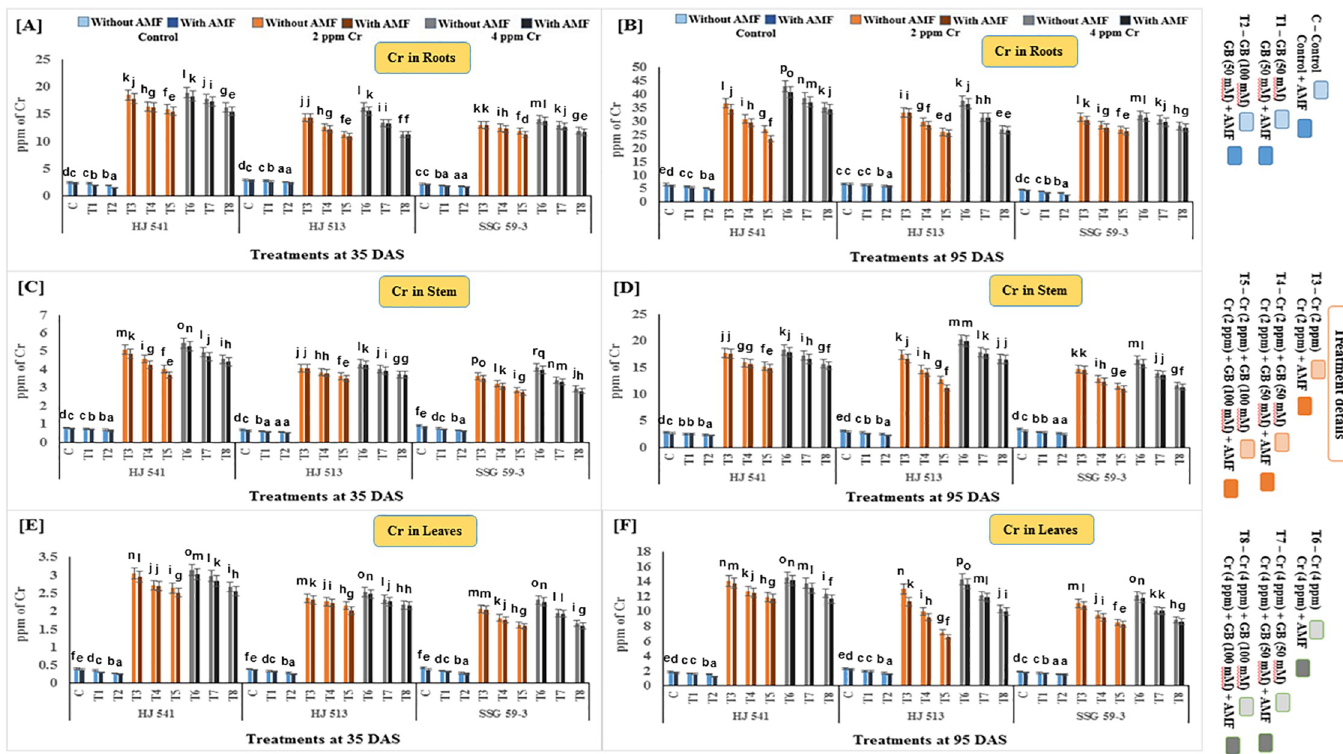
Fig 2. Effects on Cr accumulation in roots (A and B), stems (C and D) and leaves (E and F) of different varieties of sorghum exposed to GB and AMF treatments under Cr toxicity at 35 & 95 DAS, respectively. Values represent the means ± S.E., N = 3, from three independent experiments. Different letters above the bars in each column indicate significant differences among treatment means based on the least significant difference (LSD) test at P � 0.05.